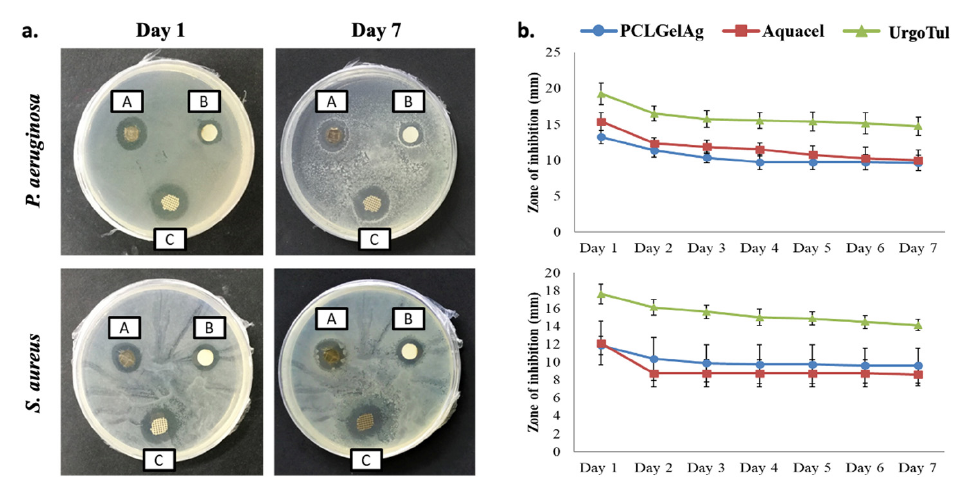
Figure 4. ( a ) Inhibition zones and ( b ) average zone diameters of the three wound dressing disks: (A) Aquacel, (B) PCLGelAg, and (C) UrgoTul against P. aeruginosa and S. aureus . The disks were observed every 24 h for 7 days.